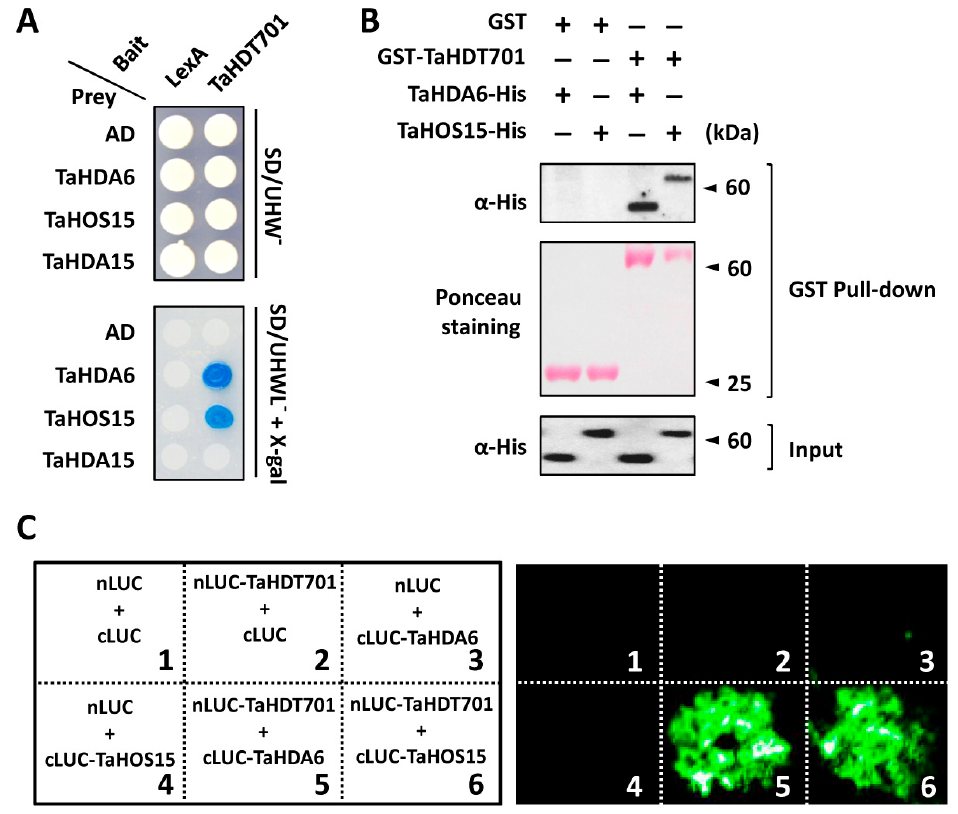
Figure 2. TaHDT701 interacts with TaHDA6 and TaHOS15. ( A ) Analysis of TaHDT701, TaHDA6, and TaHOS15 interaction in yeast-two hybrid. ( B ) In vitro glutathione S-transferase (GST) pull-down analysis of TaHDT701, TaHDA6, and TaHOS15 interaction. TaHDA6-His or TaHOS15-His was incubated with GST or GST-TaHDT701, and the GST resin-bound proteins were immunoblotted with the α -His antibody. ( C ) Luciferase complementation imaging (LCI) analysis of TaHDT701, TaHDA6, and TaHOS15 interaction. N- or C-terminal fragment of luciferase (LUC) (nLUC or cLUC) was fused with indicated proteins and indicated pairs were coexpressed in N. benthamiana through agro-infiltration.